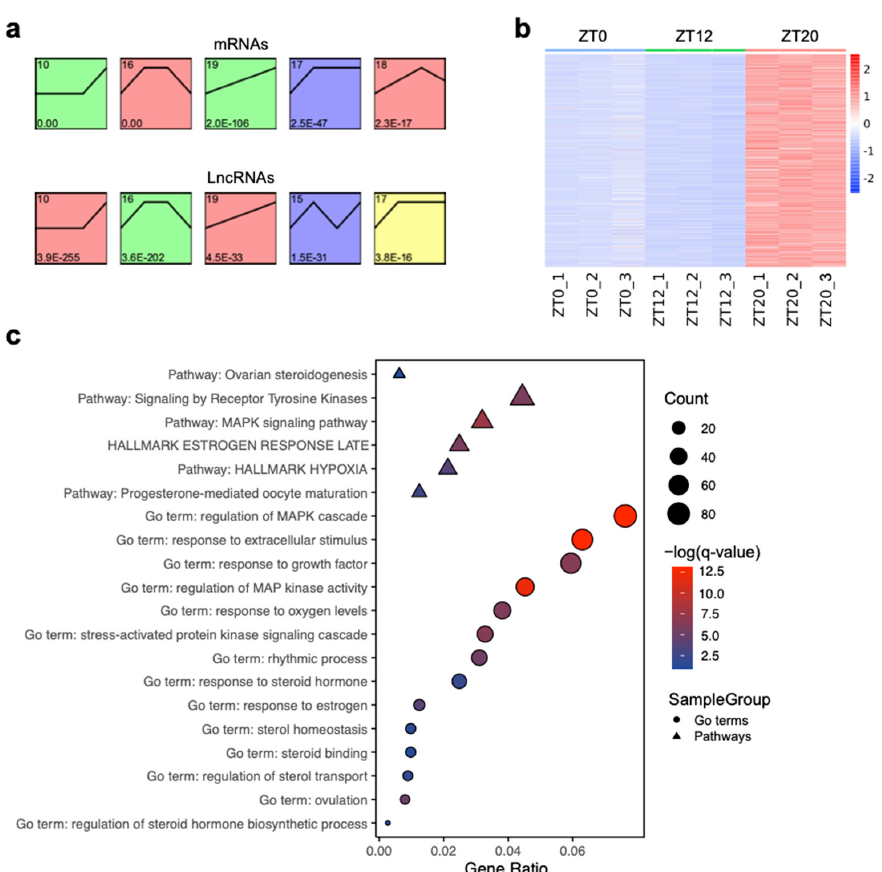
Figure 5. Expression patterns of the time-series clusters. ( a ) STEM analysis identified the temporal expression profiles of differentially expressed genes (DEGs) and differentially expressed lncRNAs (DELs) with p < 0.05. The profile number in the top left corner of each profile box was assigned by STEM. The number in the bottom left represents the adjusted p -value. ( b ) A heatmap of the transcripts’ expression in cluster 10 based on normalized data of expression values. ( c ) Enriched GO terms (circle) and pathways (triangle) of DEGs in the cluster 10 module.